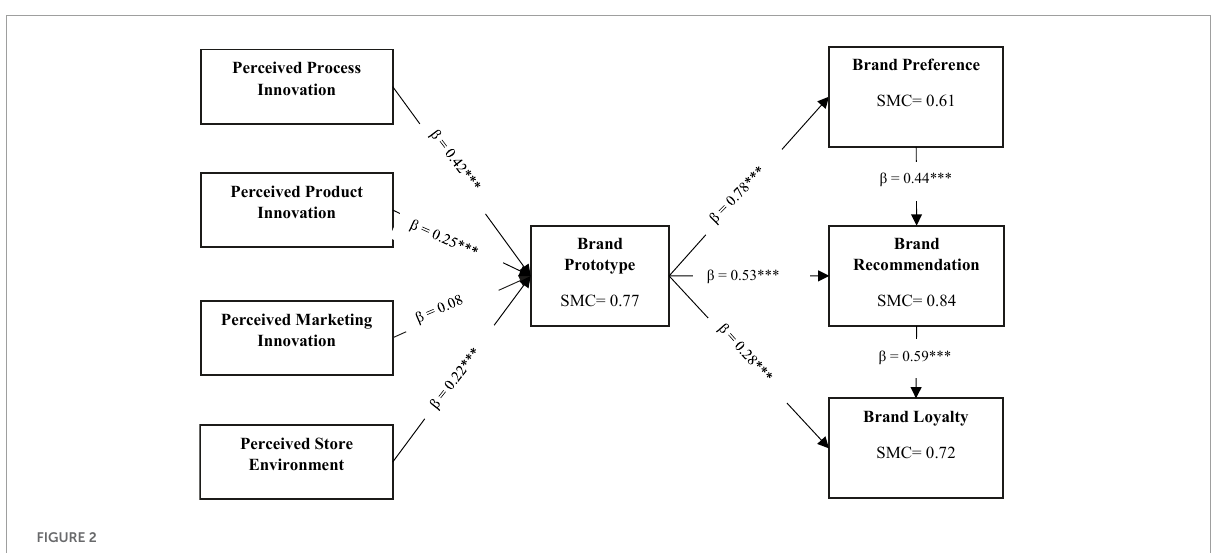
FIGURE2 Structural model relationships and squared multiple correlations